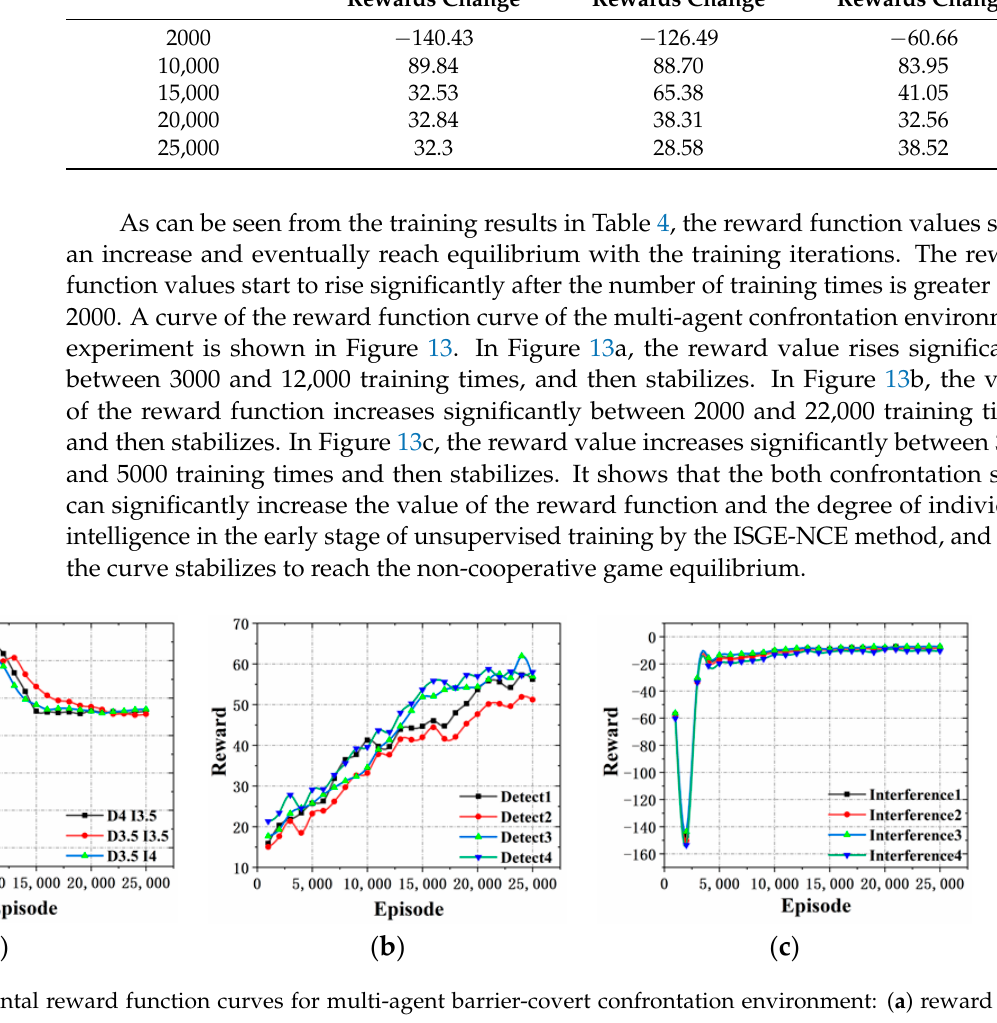
Table 4. Variation of reward function values under different acceleration conditions between both confrontation sides of the detection- interference confrontation.